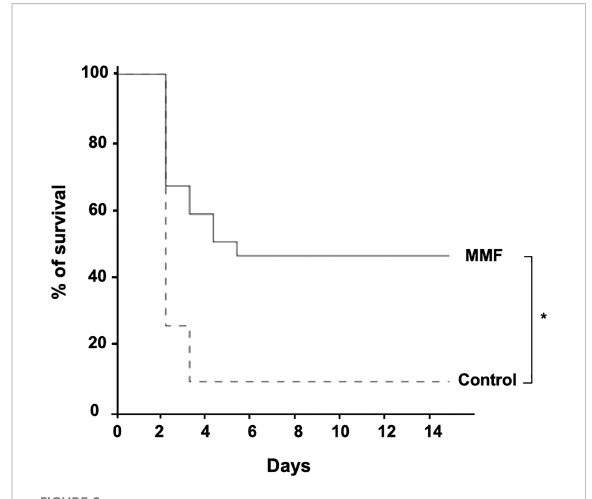
FIGURE 2 MMF improves survival during i.p. S.aureus infection. Mice were treated with MMF, which started one day before i.p. injection of 10 8 CFU S. aureus and for 3 more days (dashed line, n=25) and were compared to control mice treated with an equivalent volume of NaCl 0.9% (Dotted line, n=25). Survival was monitored for 14 days after infection. *Log-rank test, P <0.01.